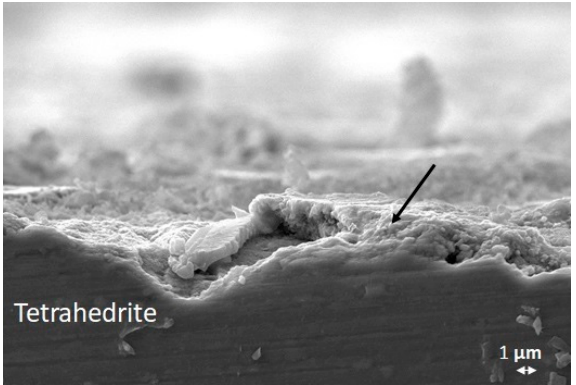
Figure 7. SEM image of cross-section of uncoated THD after ageing at 350 °C, dwelling time 48 h, in air.